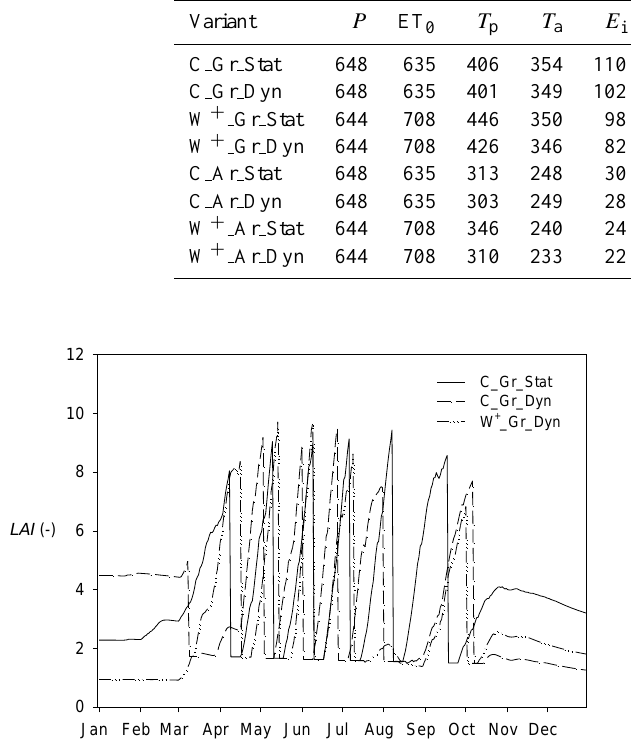
Table 4. Water balance terms (mmyr − 1 ) of monitoring point EP1 in Fig. 5 (+/ − =in/out) for the simulation year of 2003/2063. The listed terms are: P – precipitation; ET 0 – Makkink reference crop evapotranspiration; T p – potential transpiration; T a – actual transpiration; E i – interception evaporation; E s – bare soil evaporation; T rel – mean relative transpiration; ET a – total evapotranspiration; R – recharge ( P − ET a ) ; 1R veg – change of simulated recharge of dynamic versus static vegetation model; and 1R cl – change of simulated recharge with respect to current climate.